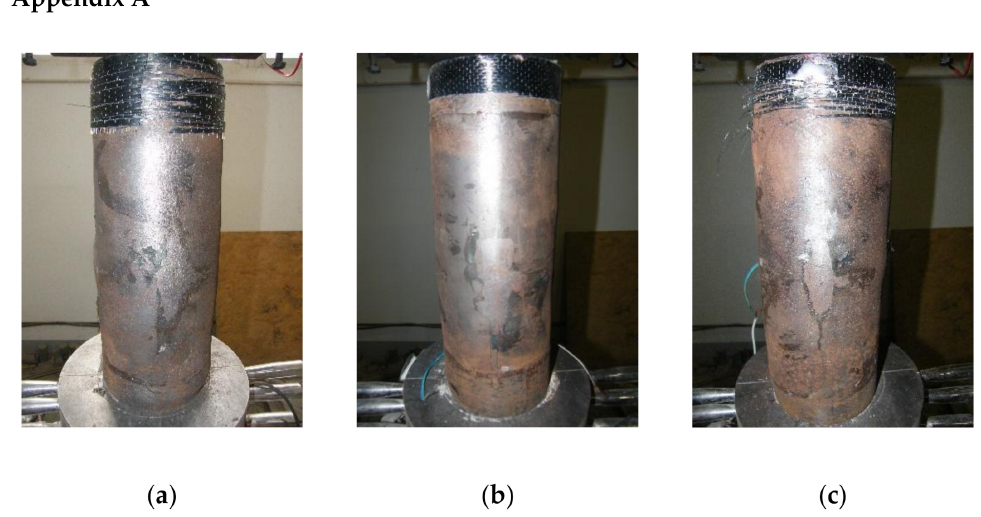
Figure A1. Failure modes of the CFT columns. ( a ) S4.5NN ( b ) S6NN ( c ) S7.5NN.